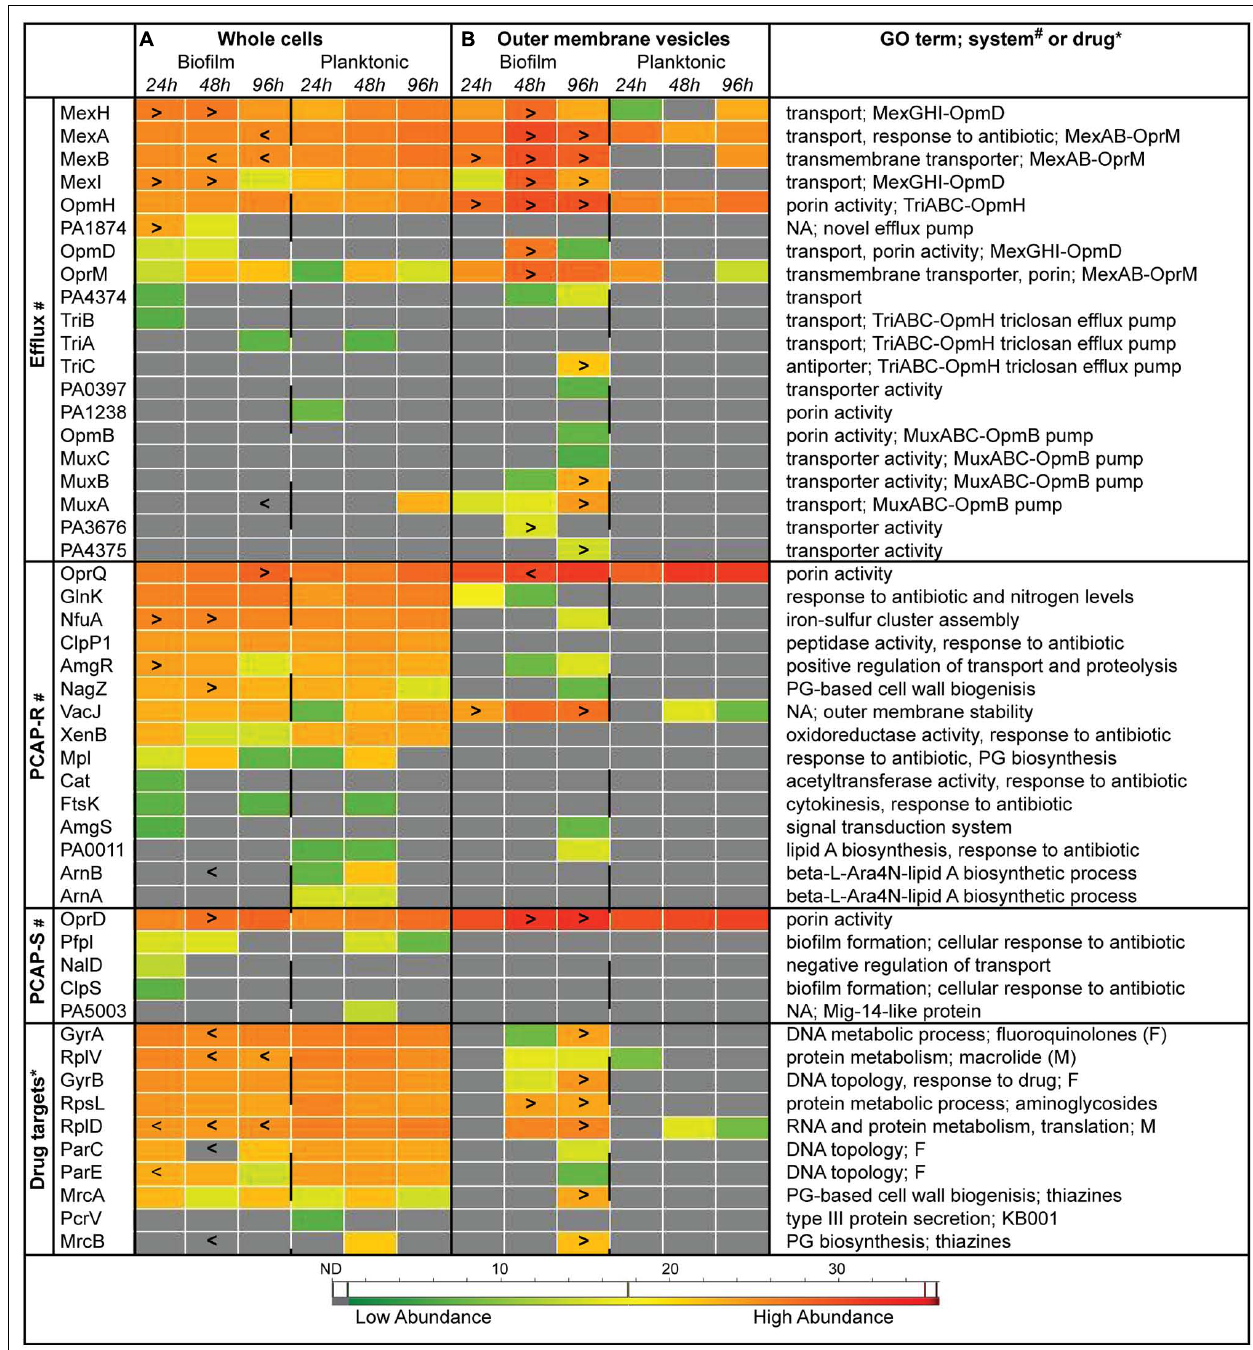
FIGURE 3 | Individual protein abundance data suggest differential antibiotic resistance strategies in Pseudomonas aeruginosa biofilms over time. Heat maps representing average protein abundance in whole cell (A) and OMV (B) replicates with warm colors depicting higher mass spectrometry intensity values. Proteins were separated into functional categories relevant to antimicrobial resistance (see “Materials and Methods” for details). Symbols: “ > ,” biofilm protein abundance is significantly greater